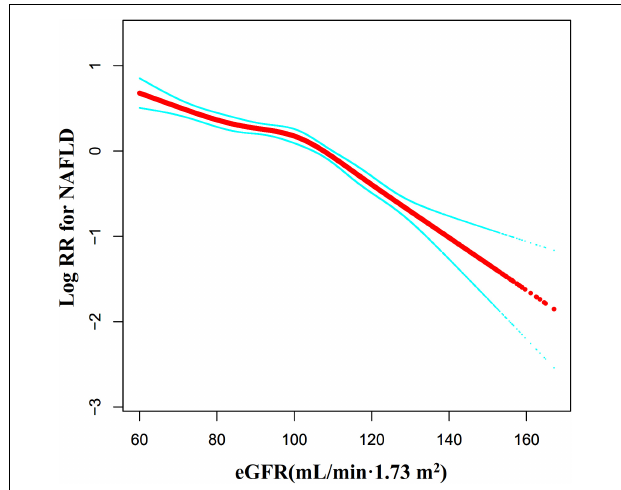
FIGURE 8 | The non-linear relationship between eGFR and NAFLD risk in participants with eGFR ≥ 60 mL/min · 1.73 m 2 . We also used a Cox proportional hazards regression model with cubic spline functions to evaluate the relationship between eGFR and NAFLD risk in participants with eGFR ≥ 60 mL/min · 1.73 m 2 . The result showed that the relationship between eGFR and NAFLD was non-linear, with the inflection point of eGFR being 103.117 mL/min · 1.73 m 2